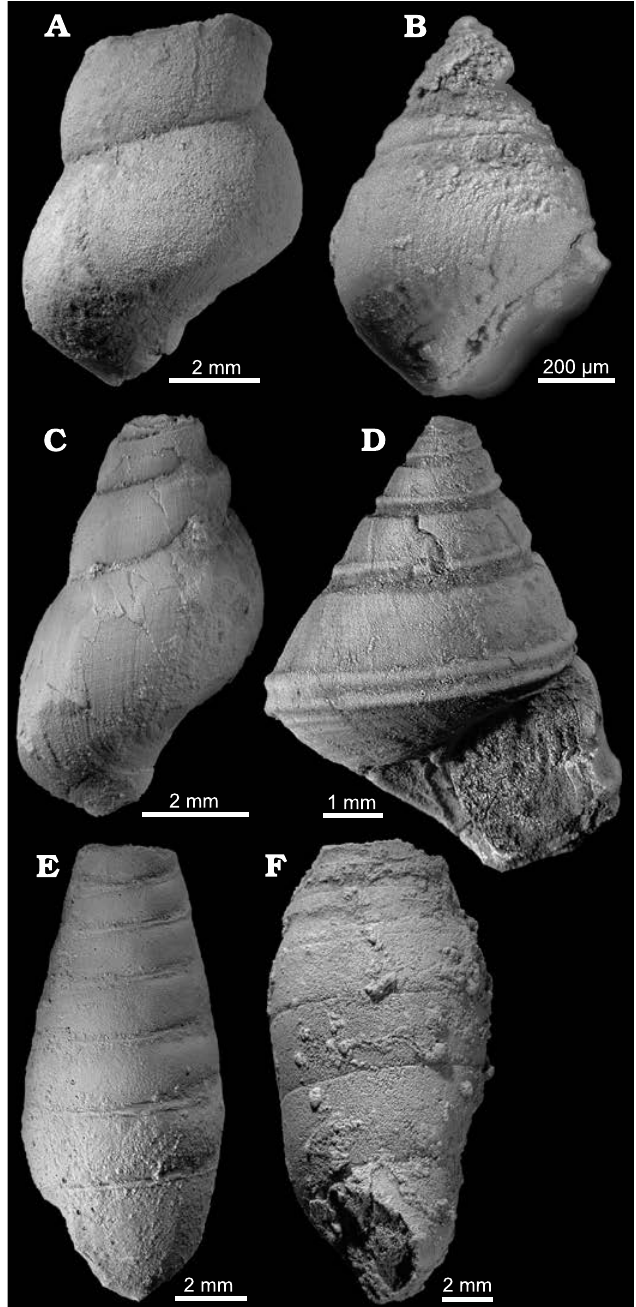
Fig. 12. Caenogastropods from Lago An torno (A) and Misurina Landslide (B–F), northern Italy, Cassian Formation, Carnian, Upper Triassic. A . Un- identified caenogastropod, PZO 12829, in lateral view. B . Coelostylina sp. 1, PZO 12691, in apertural view. C . Coelostylina sp. 2, PZO 12692, in lat- eral view. D . Flemingella bistriata (Münster, 1841), PZO 12713, in aper- tural view. E . Coelochrysalis pupaeformis (Münster, 1841), PZO 12714, in lateral view, with constriction of last whorl. F . Coelochrysalis pupaeformis (Mün ster, 1841), PZO 12715, deformed specimen in lateral view, showing constriction of last Material .—Thirteen specimens, 7 from bulk samples, 6 from surface samples; 10 from Lago Antorno (PZO 12812–12814, 3 figured specimens; PZO 12811, 7 specimens); 3 from